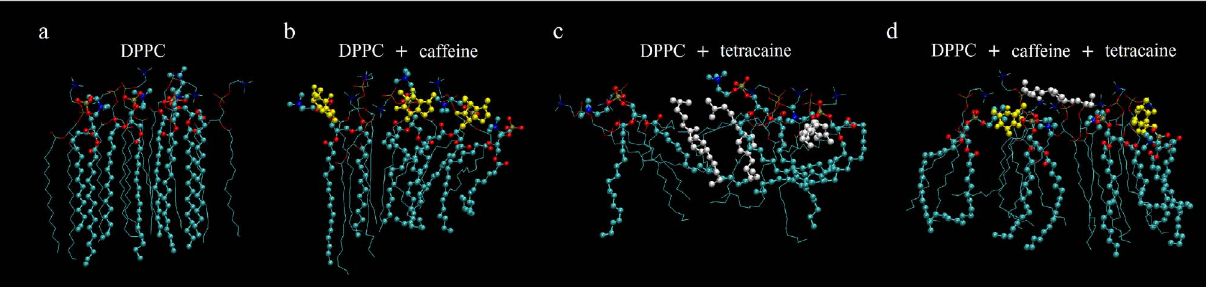
Figure 5. Molecular Dynamic snapshots of a DPPC/drugs system. (a) Control membrane showing a high ordered system. Red and blue dots highlight the polar region of the lipids (oxygen and nitrogen, respectively), chains of light blue dots the hydrophobic tails. (b) Caffeine (yellow) interacts mostly with the hydrophilic heads. (c) Tetracaine (white) inserts inside the membrane disrupting visibly the lipids organization at the hydrophobic region. (d) The combination of caffeine and tetracaine induces less disorder. The snapshots correspond to positions obtained 15 ns after the start of the simulation.